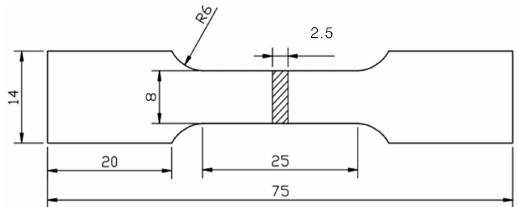
Figure 1. Tensile specimen size at room temperature (unit: